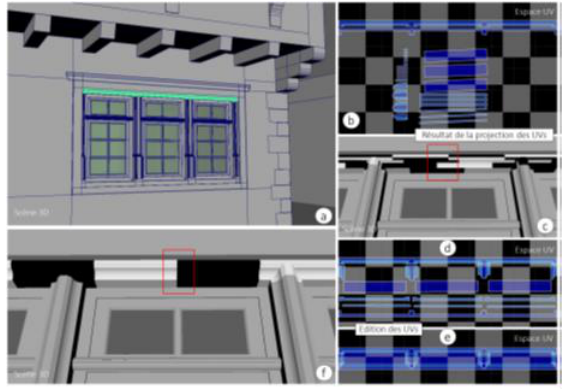
Figure 8: Detail of modelling and texture management